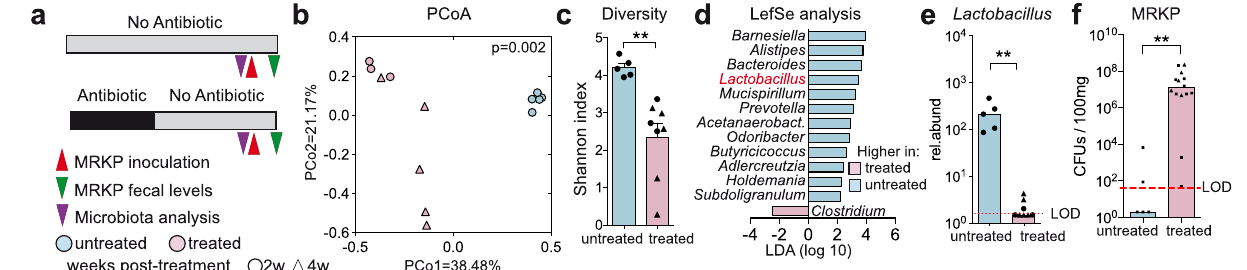
Fig. 2 | Antibiotic treatment depletes Lactobacillus and promotes gut coloni- zation by multidrug-resistant K. pneumoniae (MRKP) in mice. a Schematic representationoftheexperimentalmodel.Miceweretreatedwithantibiotics(AVN) for 1 week or left untreated. Two or 4 weeks (w) after antibiotic cessation fecal sampleswerecollectedformicrobiotaanalysisand,subsequently,micewereorally gavaged with MRKP. b Principal coordinate of analysis (PCoA) of the Bray – Curtis distances at the OTU level. The microbiota composition of untreated animals is signi fi cantly different from the microbiota of mice that were left to recover after antibiotic cessation. PERMANOVA, p =0.002, N =5 and 8 mice per group. c Mice thatwereallowed to recover afterantibioticcessation donot recoverthe bacterial diversity levels of untreated mice. Diversity was calculated applying the Shannon index at the OTU level. Two-sided T -test, ** p =0.003, N =5 and 8 mice per group. d LEfSe analysis was performed to identify the most discriminative microbiota changes between samples collected from untreated mice and samples collected 2